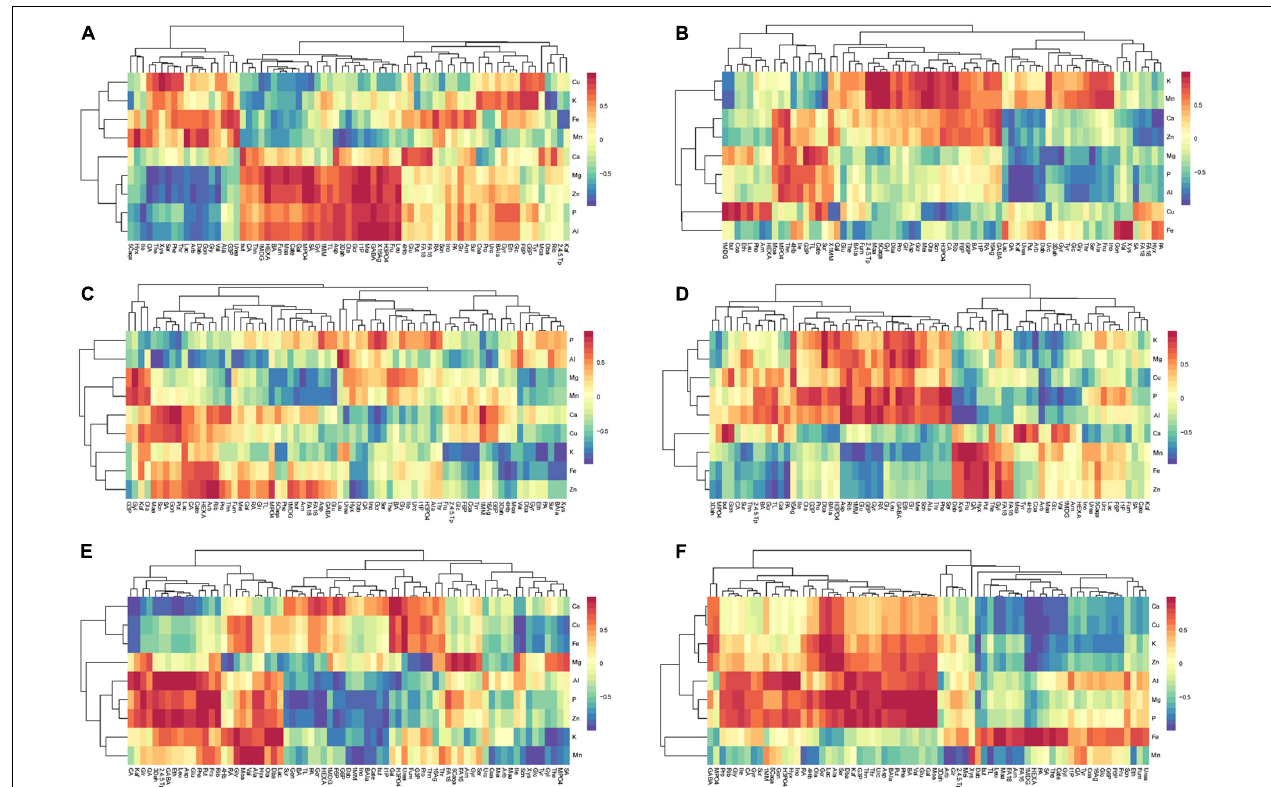
FIGURE 7 | The heat maps of the correlation between needle mineral elements and needle metabolites in CK groups and OTC groups at the three altitudes. (A) , H1CK; (B) , H1OTC; (C) H2CK; (D) H2OTC; (E) H3CK; and (F) H3OTC. Horizontal axis indicates the needle metabolites with significant changes under warming conditions; vertical axis indicates the needle mineral elements with significant changes warming conditions. CK, control groups; OTC, warming groups. H1, 3,500 m; H2, 3,000 m; H3, 2,600 m. Abbreviations were listed in Supplementary Table 1